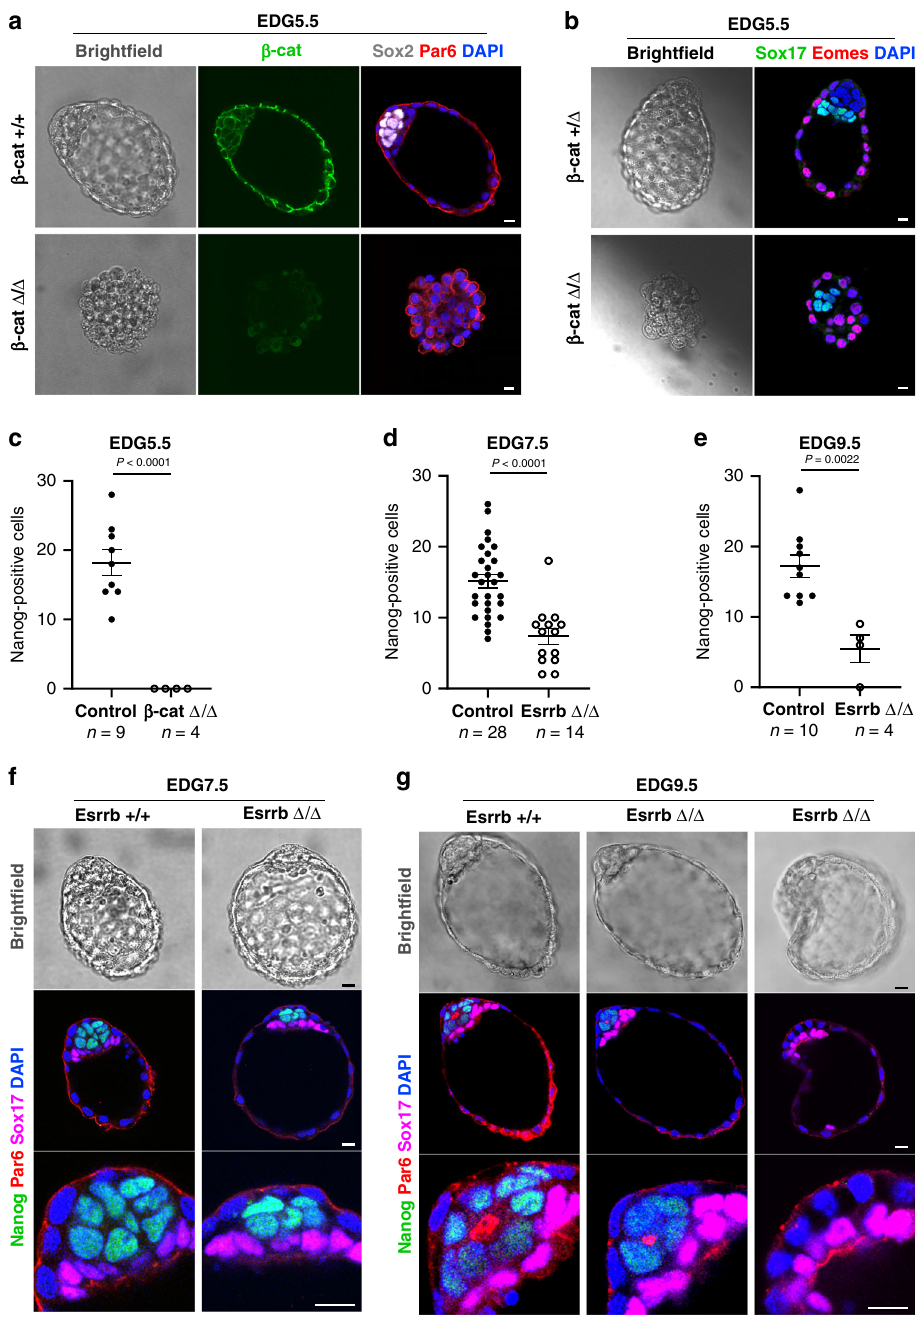
Fig. 6 Loss-of-function analysis of β -catenin and Esrrb during diapause. a β -catenin control ( + / + ) and knockout ( Δ / Δ ) embryos isolated at EDG5.5 and stained for β -catenin, Sox2, Par6 and DAPI. b β -catenin control ( Δ / + ) and knockout ( Δ / Δ ) embryos isolated at EDG5.5 and stained for Sox17, Eomes and DAPI. c The number of epiblast cells in β -catenin control ( + / + and + / Δ ) and knockout ( Δ / Δ ) embryos at EDG5.5 based on Nanog expression. Data represent mean ± SEM, n = number of embryos, two-tailed unpaired Student ’ s t test, the exact P value is noted in the fi gure. d The number of epiblast cells in Esrrb control ( + / + and + / Δ ) and knockout ( Δ / Δ ) embryos at EDG7.5 based on Nanog expression. Data represent mean ± SEM, n = number of embryos, two-tailed unpaired Student ’ s t test, the exact P value is noted in the fi gure. e The number of epiblast cells in Esrrb control ( + / + and + / Δ ) and knockout embryos ( Δ / Δ ) at EDG9.5 based on Nanog expression. Data represent mean ± SEM, n = number of embryos, two-tailed unpaired Student ’ s t test, the exact P value is noted in the fi gure. f Esrrb control ( + / + ) and knockout ( Δ / Δ ) embryos isolated at EDG7.5 and stained for Nanog, Par6, Sox17 and DAPI. g Esrrb control ( + / + ) and knockout ( Δ / Δ ) embryos isolated at EDG9.5 and stained for Nanog, Par6, Sox17 and DAPI. Scale bars, 10 µ